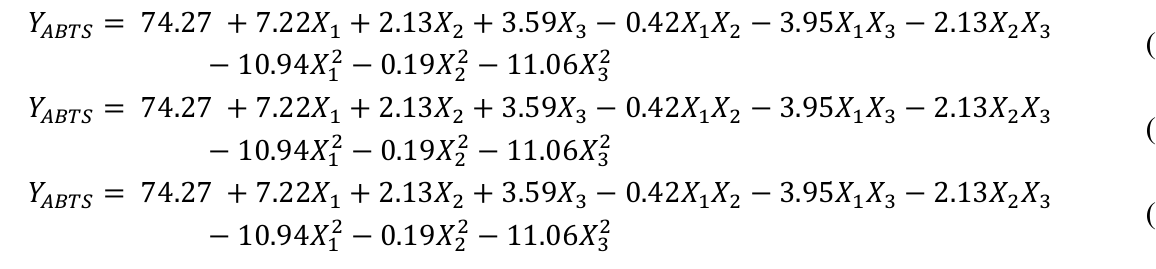
Figure 1. Correlations between predicted and experimental total phenolic content and antioxidant capacity. ( A ) Phenolic content; ( B ) 2,2′-azino-bis-3-ethylbenzothiazoline-6- sulphonic acid (ABTS) antioxidant capacity; ( C ) 1,1-diphenyl-2-picrylhydrazyl (DPPH) free radical scavenging capacity; and ( D ) Cupric reducing antioxidant power